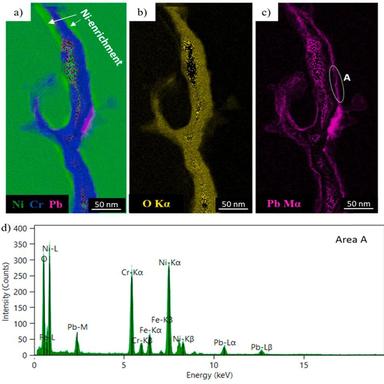
PbSCC crack region, close to the tip generated during the SCC test in 0.3 M NaOH containing 5000 ppm PbO. Elemental maps for (a) Ni Kα (green), Cr Kα (blue) and Fe Kα (red) combined, (b) O Kα (c) Pb Mα extracted from the STEM-EDX spectrum imaging dataset. EDX spectrum from region (d) A, which is marked in (c), showing an enrichment of Pb. White arrows indicate Ni enrichment adjacent to the crack. Note that the crack propagated out of the plane.